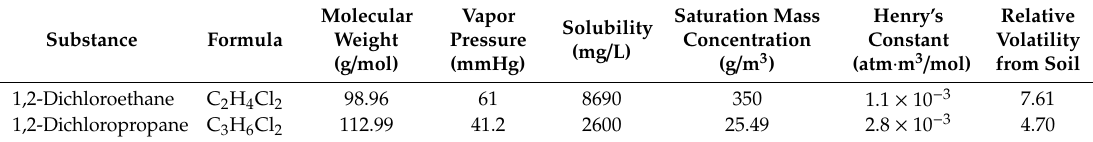
Figure 6. Average wind distribution on the study site in 2015. Table 1. Physico-chemical characteristics of 1,2-dichloroethane and